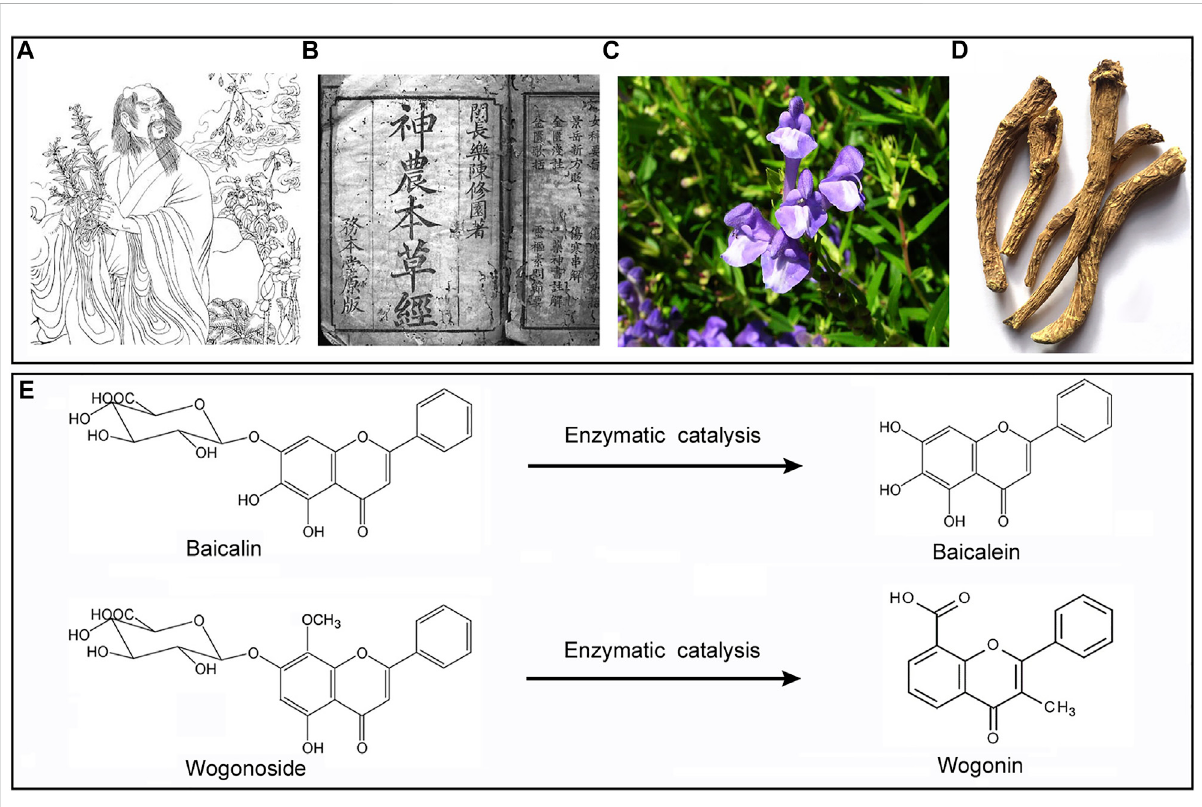
FIGURE 1 SBGwasoriginallydocumentedinShennong ’ s (A) ShennongmateriaMedica (B) .Theplant (C) ,dryroot (D) ,andthechemicalstructureofWGS/ WGI (E)